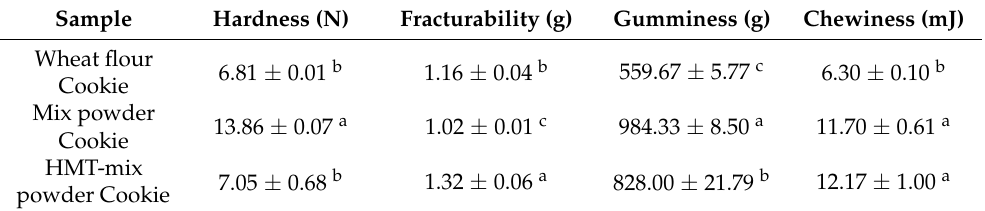
Table 9. Textural properties of wheat flour cookies, mix powder cookies and HMT-mix powder